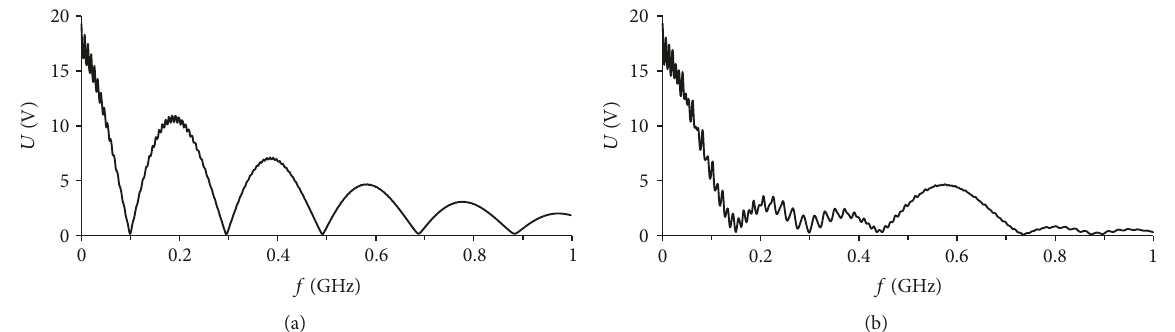
Figure 17: Simulated spectrum of the signal at the far end of a structure without (a) and with (b) wire